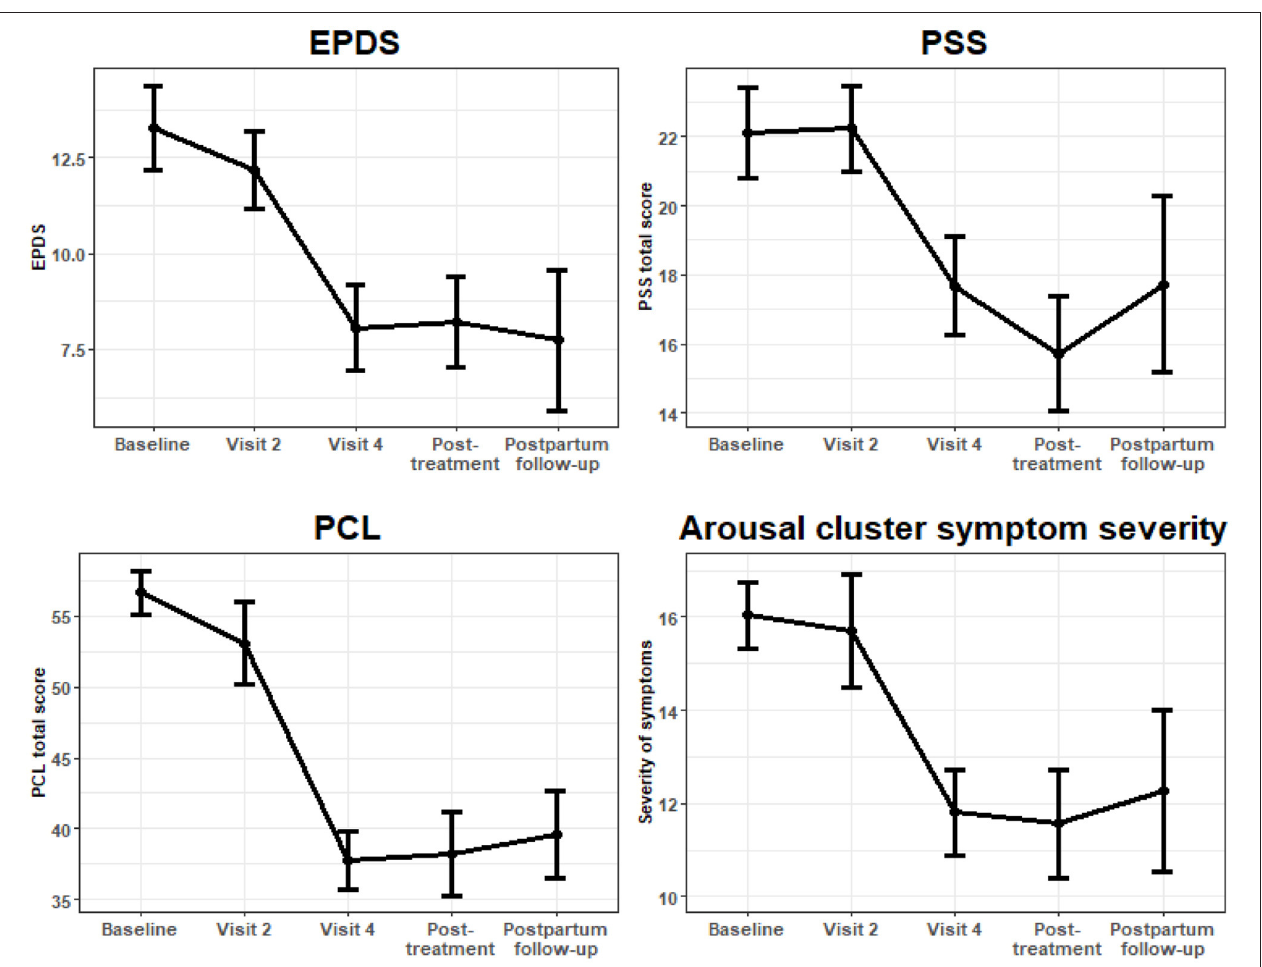
FIGURE 2 | Longitudinal outcomes of symptom severity scales plotted with mean standard errors at each